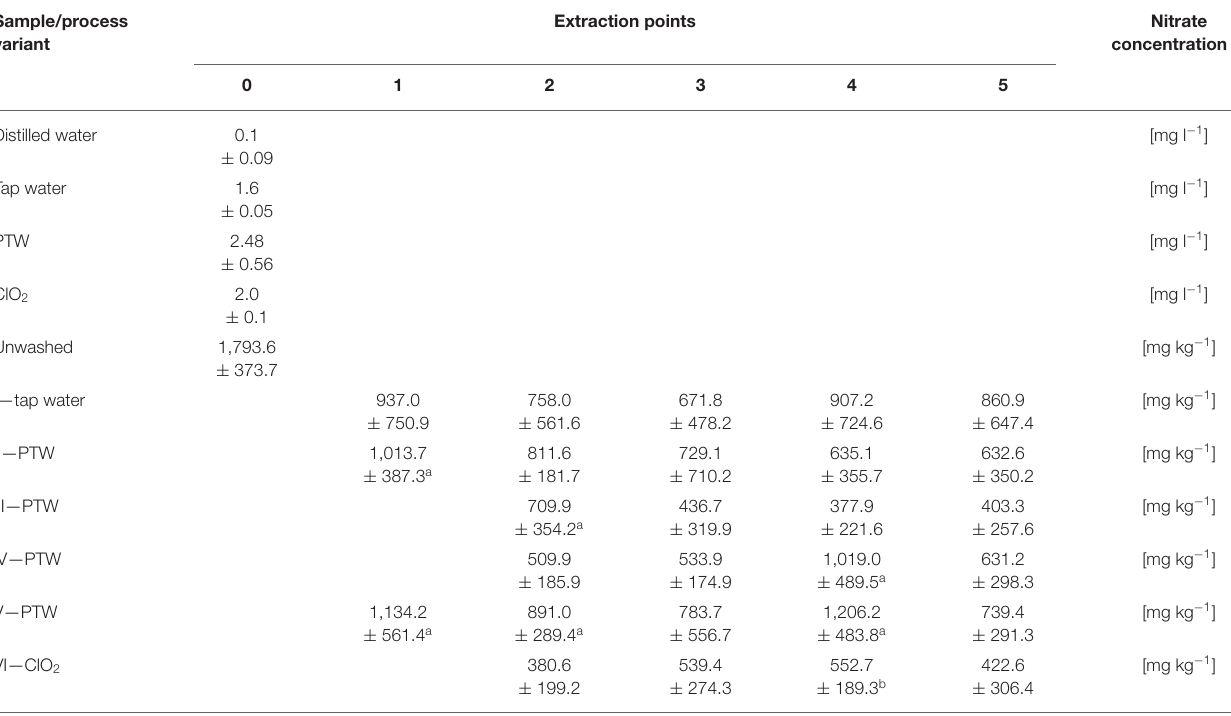
TABLE 10 | Nitrate concentrations of fresh-cut unwashed and washed